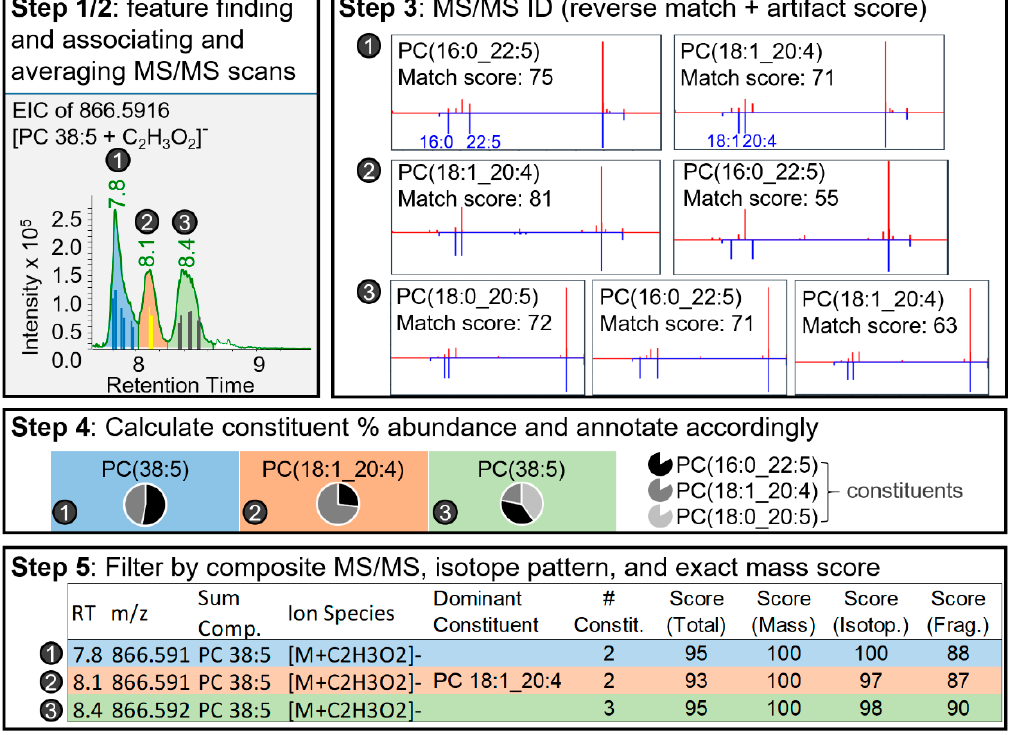
Figure 2. Steps of Lipid Annotator identification algorithm using actual data from National Institute of Standards and Technology (NIST) SRM 1950 human blood plasma acquired in negative polarity.